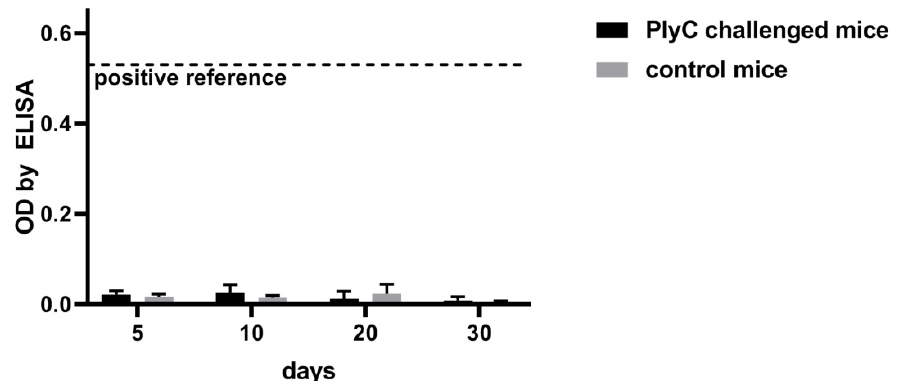
Figure 6. PlyC-specific IgE in mice challenged with PlyC. Mice were injected intraperitoneally with PlyC in PBS (100 µg/mouse in 0.2 mL) or PBS (0.2 mL) control. Serum samples were collected and tested against PlyC by ELISA on indicated days. The positive reference was the average signal to ovalbumin in allergic mice. No statistically significant difference was detected between PlyC- challenged and control mice, but statistical significance was found between the ovalbumin positive reference and all presented groups (adj. p < 0.001).